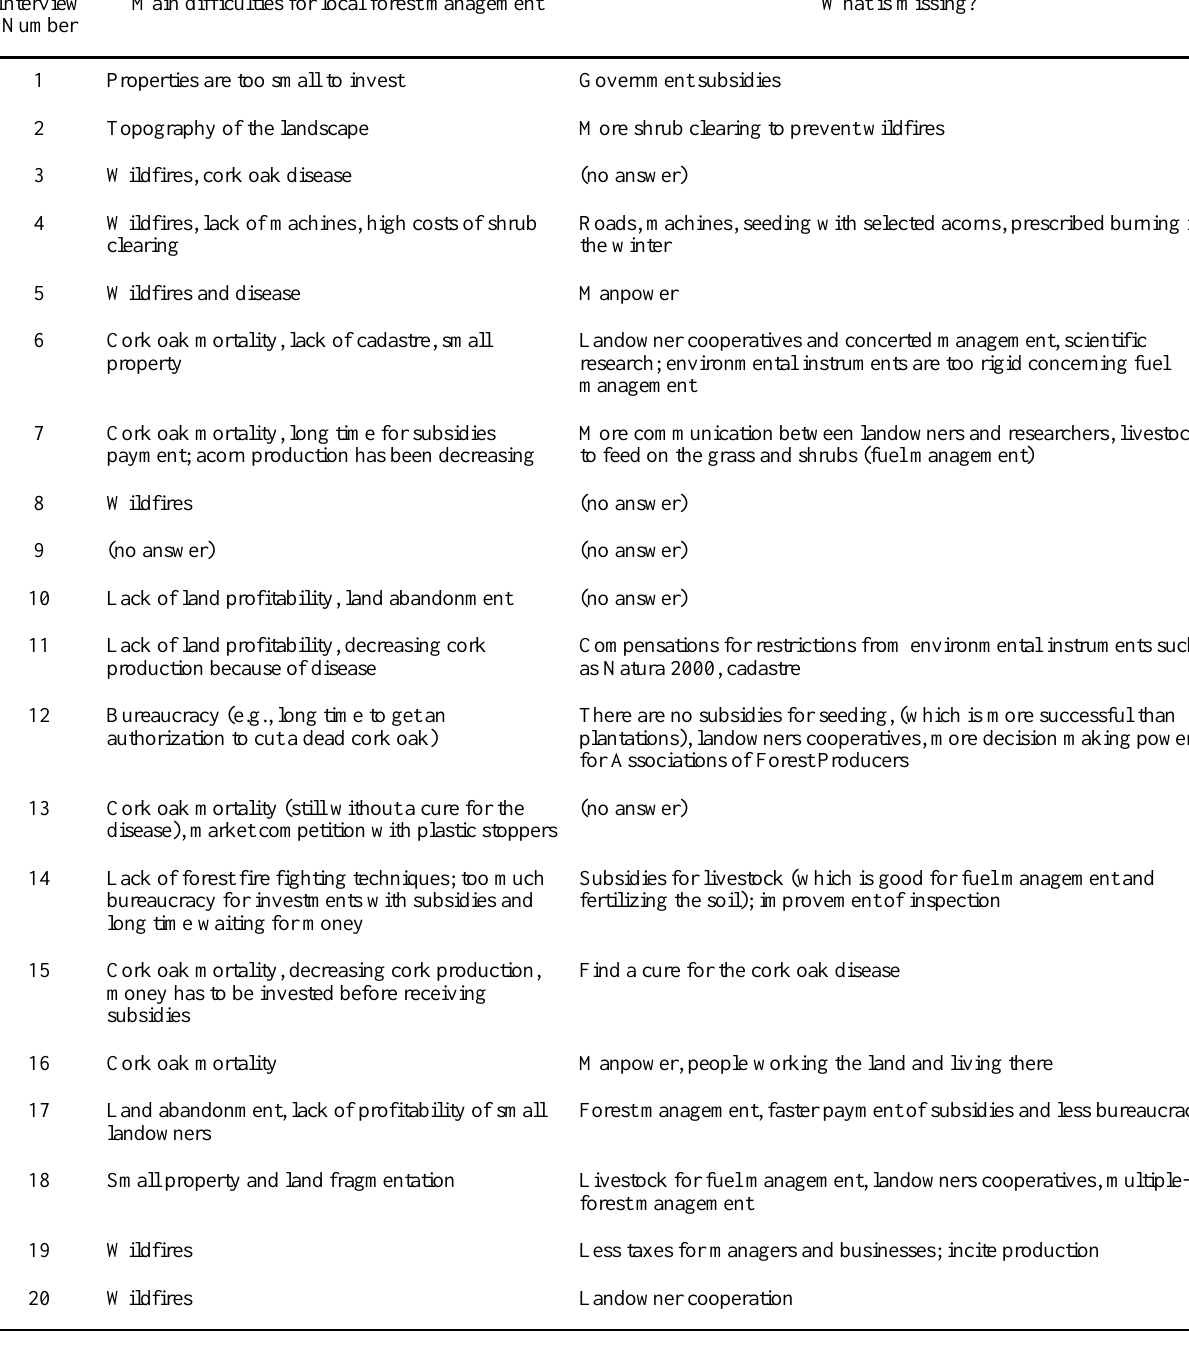
Table 4. Management difficulties and needs identified by landowners. Table shows direct quotations from